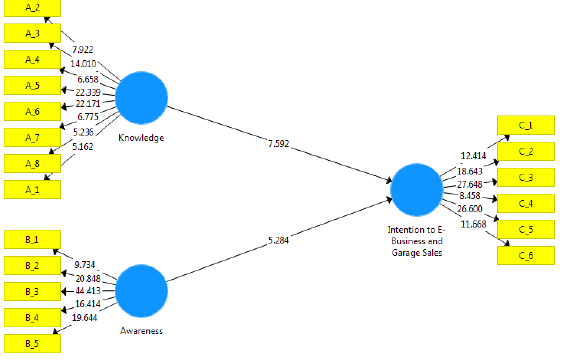
Fig. 4. The result of hypothesis testing using PLS